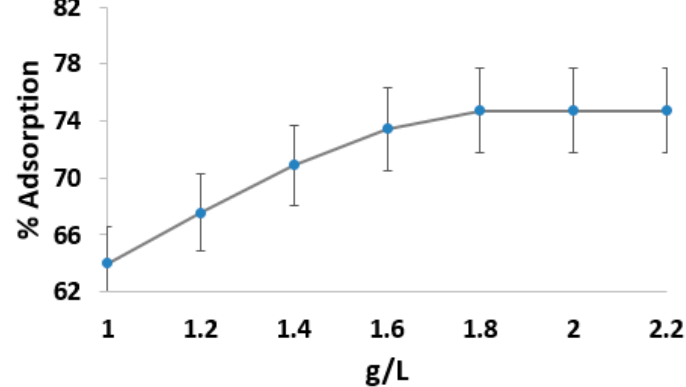
Figure 3. Effect of adsorbent dosage on the percentage of As (III) adsorption. Error bars represent the standard error from triplicate experiments.